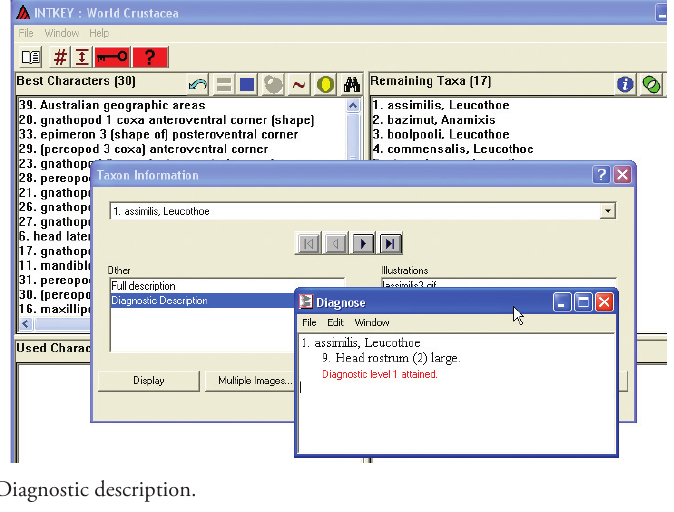
Figure 55. Diagnostic description.